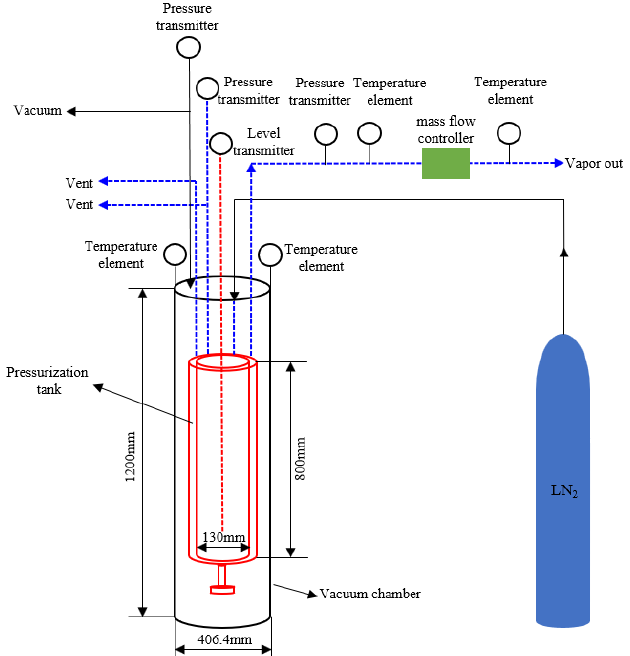
Figure 3. Schematic diagram of the experimental apparatus. This figure is adapted from